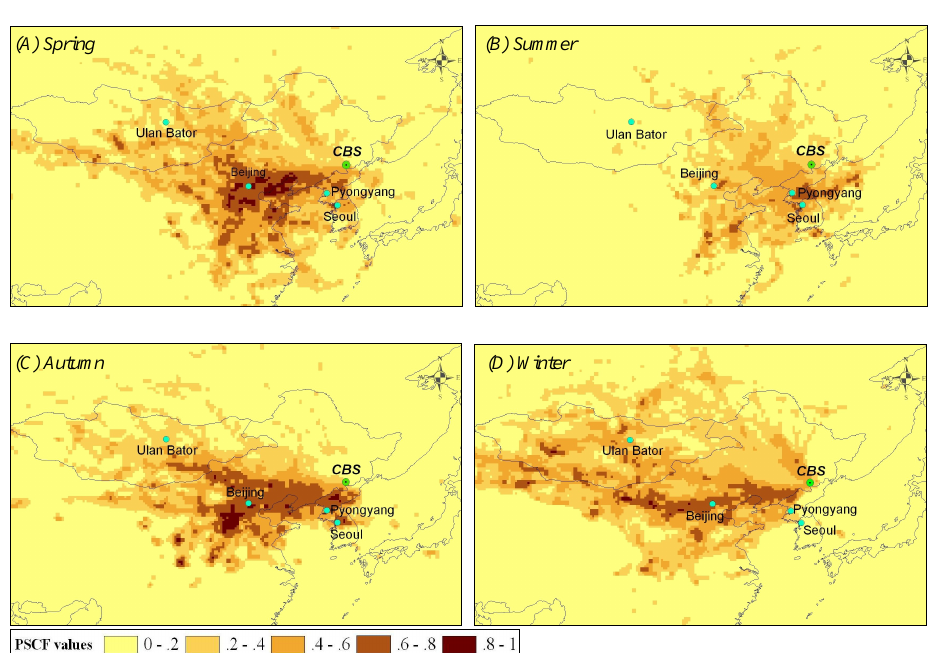
Fig. 10. Seasonal PSCF results of TGM at